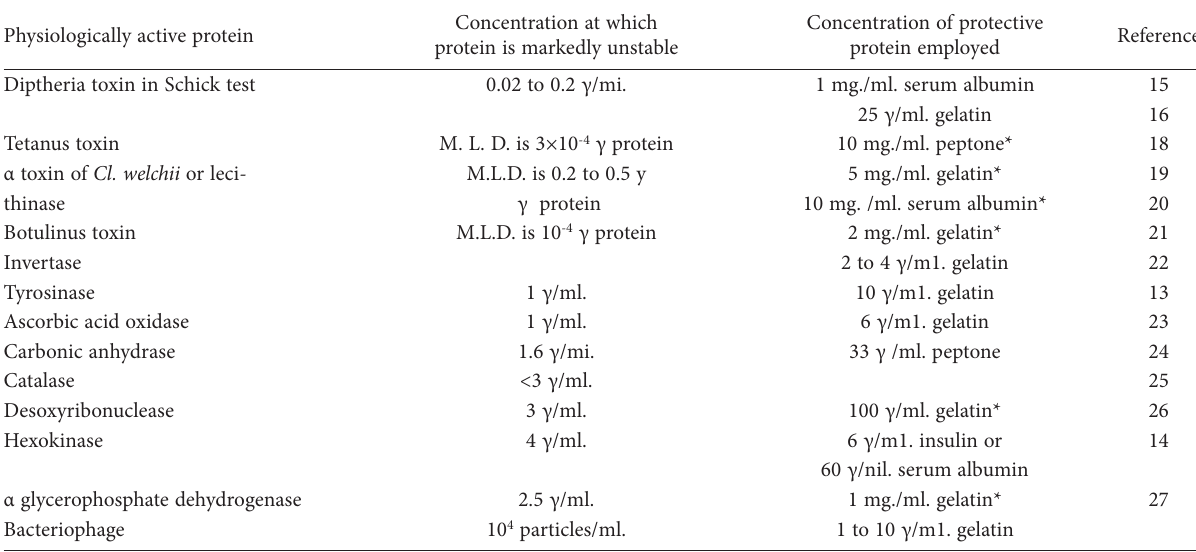
Table IV. A summary of data from the literature concerning physiologically active proteins which are unstable when highly diluted, includ- ing the concentration at which the protein is usually assayed and at which its lack of stability is noted, and the concentration of protective protein employed to stabilize